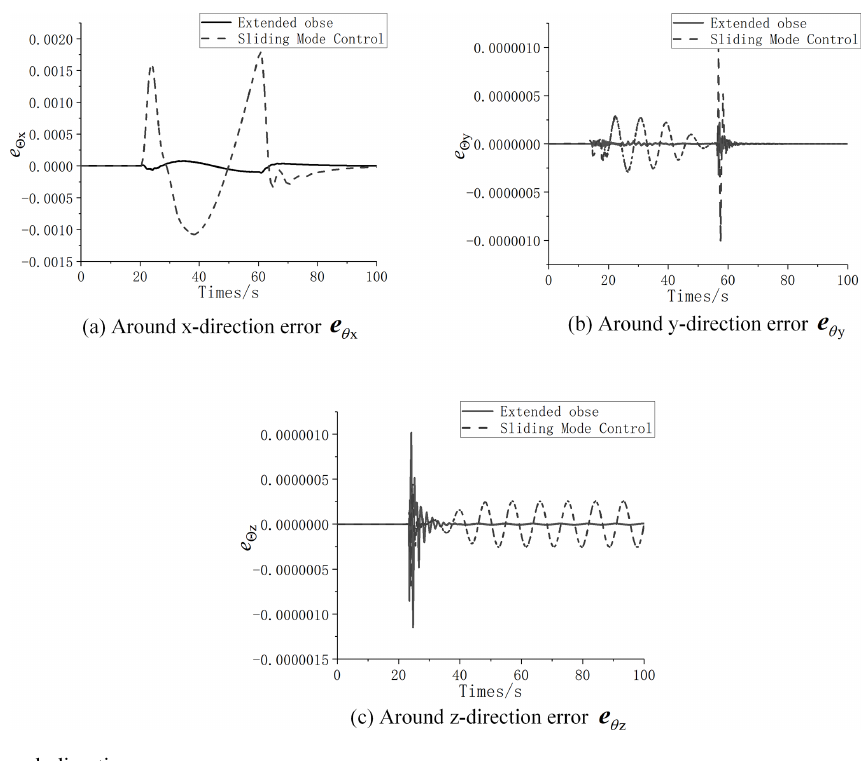
Figure 9. Error e θ in each direction.